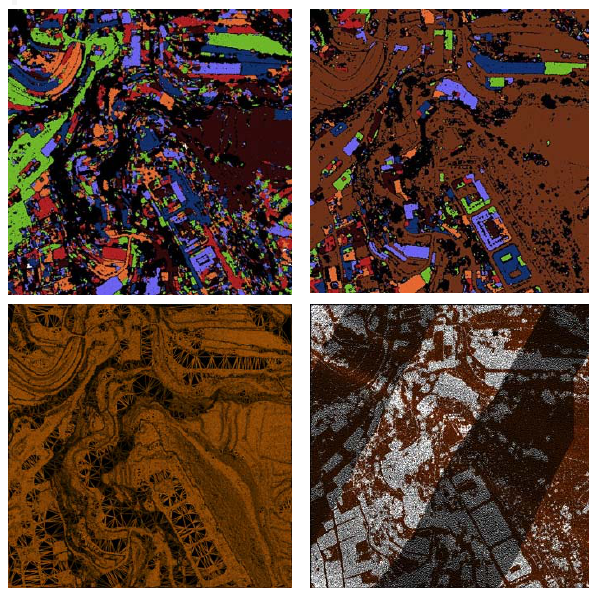
Figure 3. Upper: Terrain segments generation process; Lower: left) Definitive triangulation densification; right) Final classification of ground data.